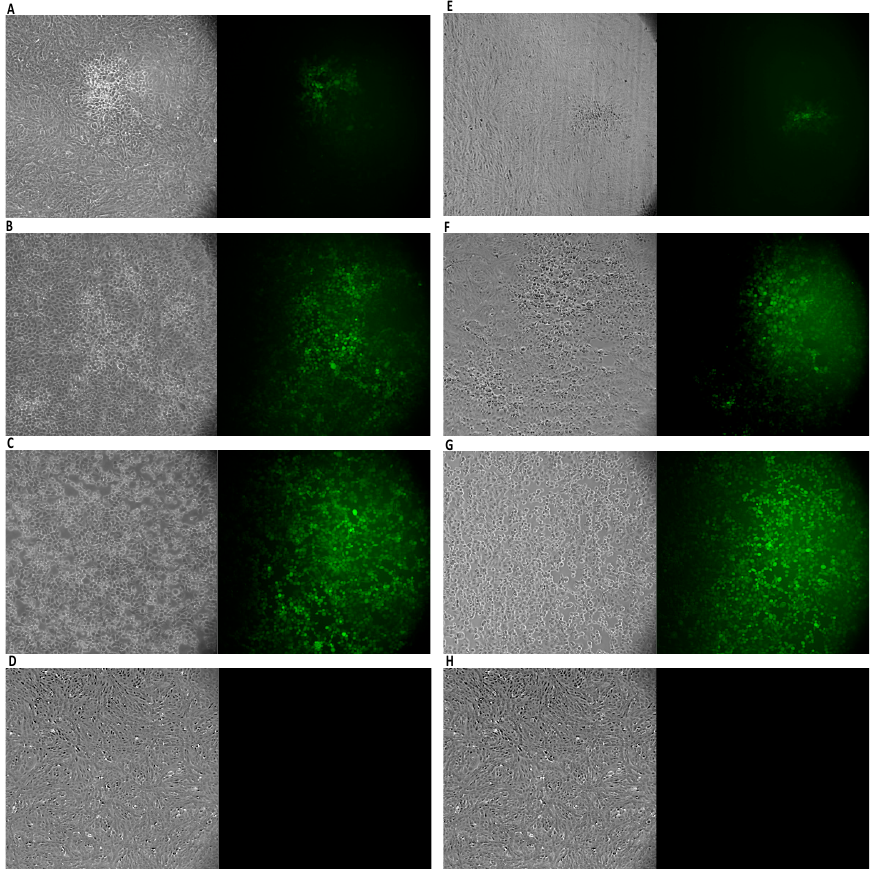
Figure 8. Antiviral activity of Oftasecur against GFP-engineered HSV-1. Plaques were viewed with bright-field and fluorescent microscopy: treatments at a 12.5 ( A ) and 3.12 ( B ) μ L; CTRL − : cells infected with the virus ( C ); CTRL+: cells uninfected ( D ). Antiviral activity of Visuprime against GFP- engineered HSV-1. Plaques were viewed with bright-field and fluorescent microscopy: treatments at a 6.25 ( E ) and 1.56 ( F ) μ L; CTRL − : cells infected with the virus ( G ); CTRL+: cells uninfected ( H ).